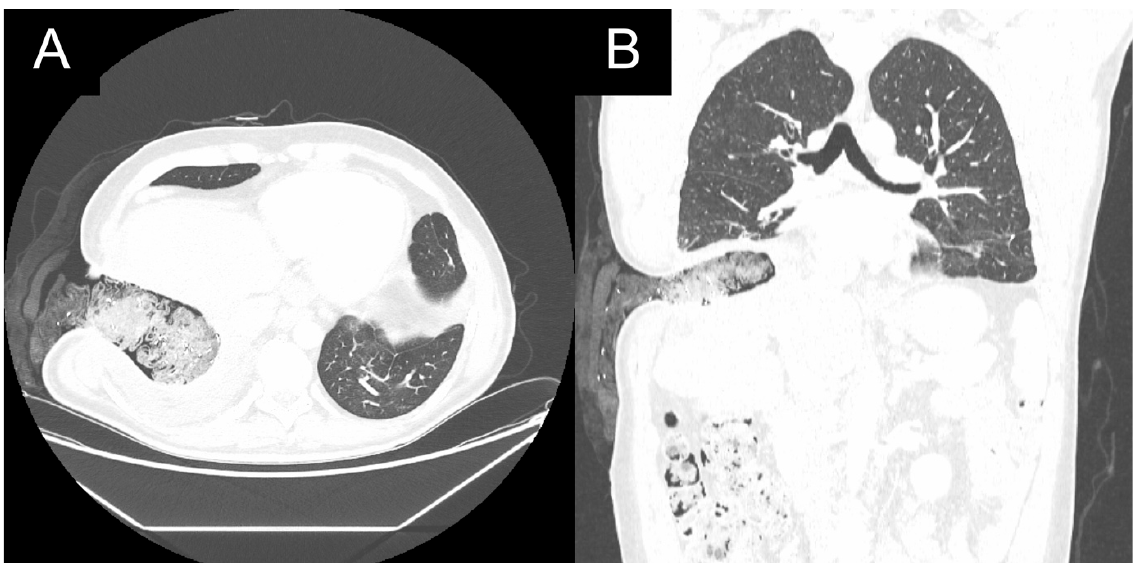
Figure 7. Postoperative chest CT in ( A ): axial and ( B ): coronal views of patient 1 with open window thoracostomy.